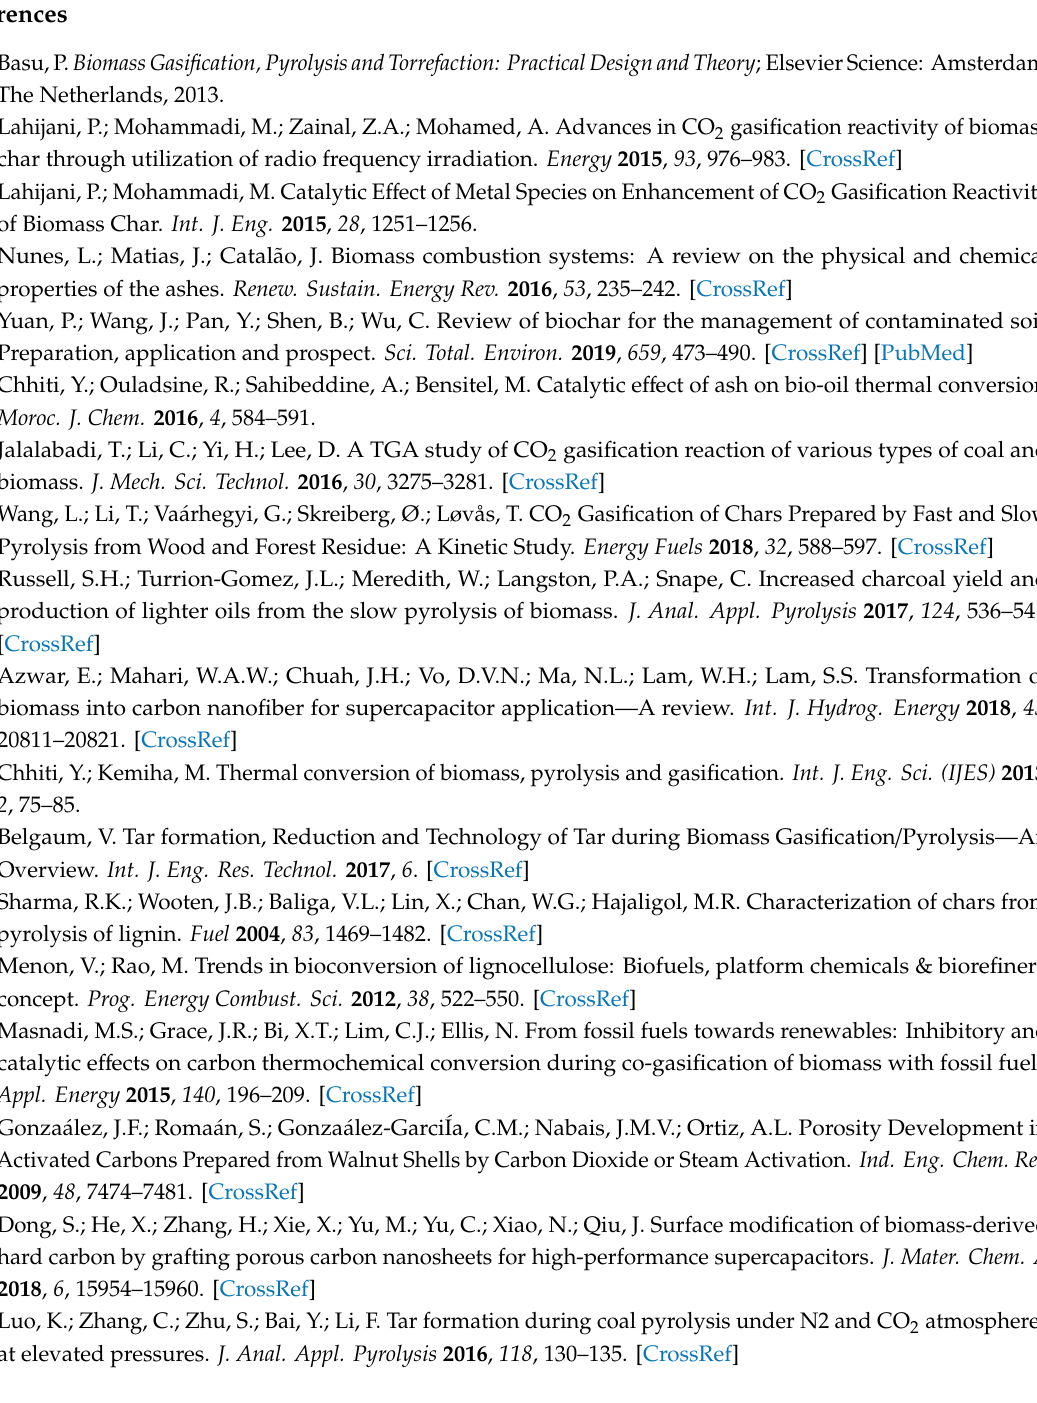
Figure S1: SEM image of particle distribution and surface morphology from Bio50-N 2 water washed char at 600 ◦ C, Figure S2: Vaporization of LiNaK 2 (CO 3 ) under N 2 at 900 ◦ C inside TGA column. Covers crucible, hookers and other